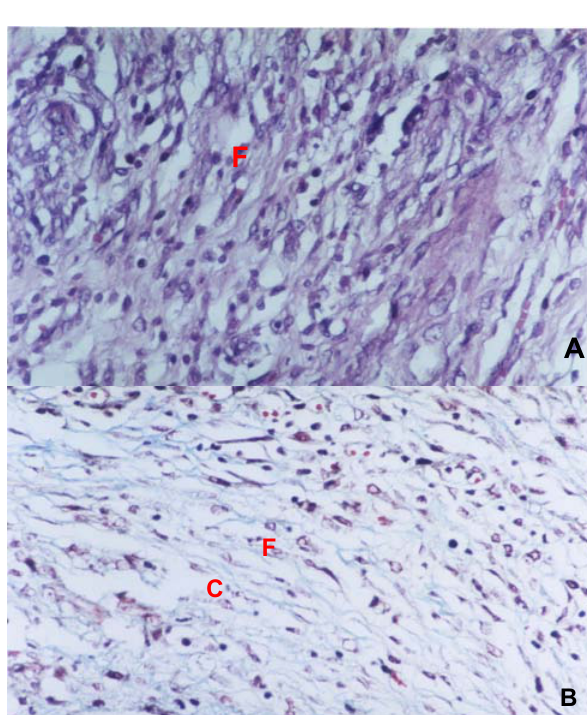
FIGURA 4 – Fotomicrografias do cólon de rato GC7 corado pela técnica hematoxilina - eosina. (A) e tricrômico de masson (B). Em A observa-se inflamação subaguda com polimorfonucleares (P) e proliferação fibroblás - tica (F); em B inflamação subaguda com congestão (C), edema (E) e polimorfonucleares (P).